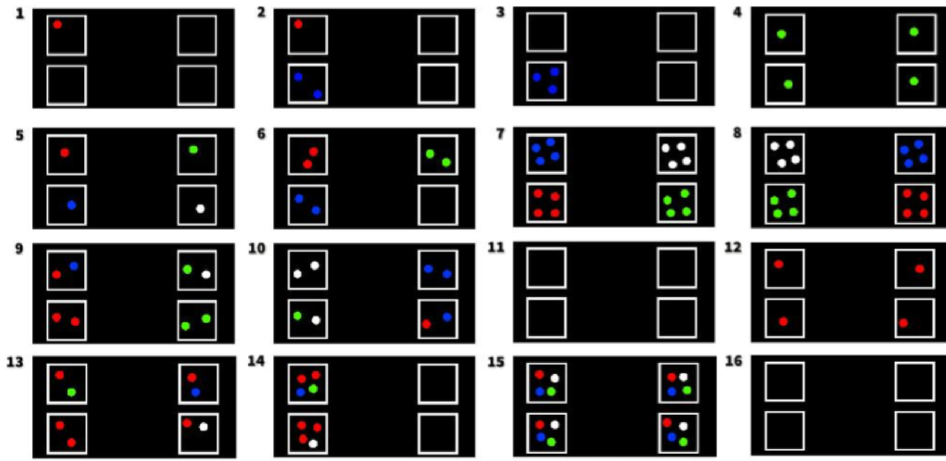
Figure 3. Target token distribution for each of the 16